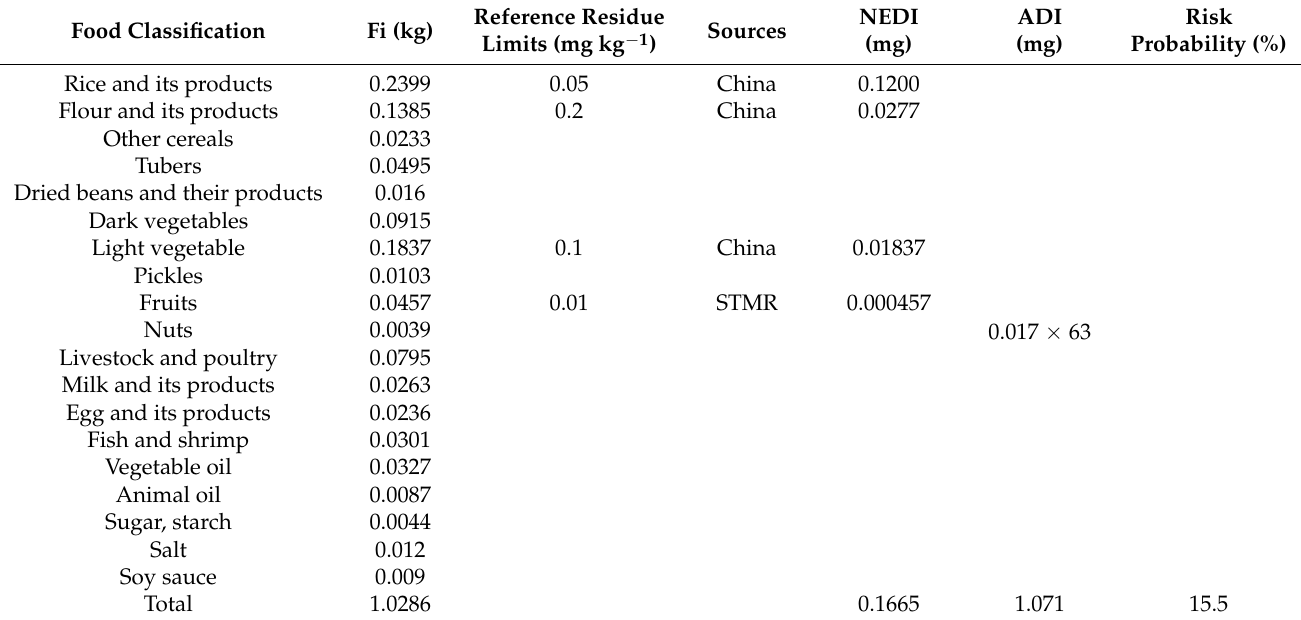
Table 3. Dietary risk assessment of benziothiazolinone in